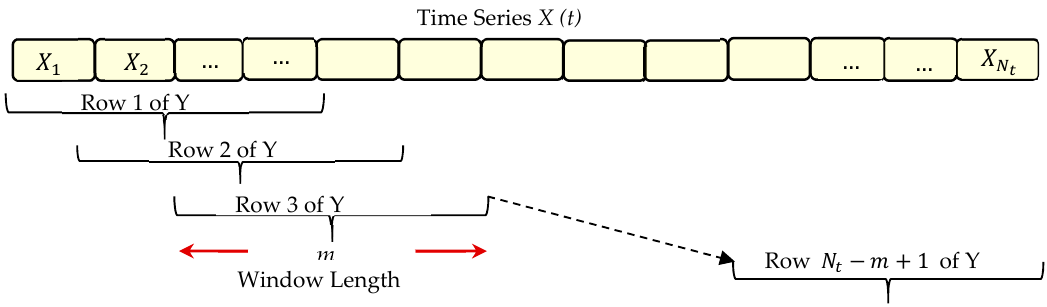
Figure 4. Representation of a given time series when considering for example a window length m = 4 to construct the trajectory matrix.